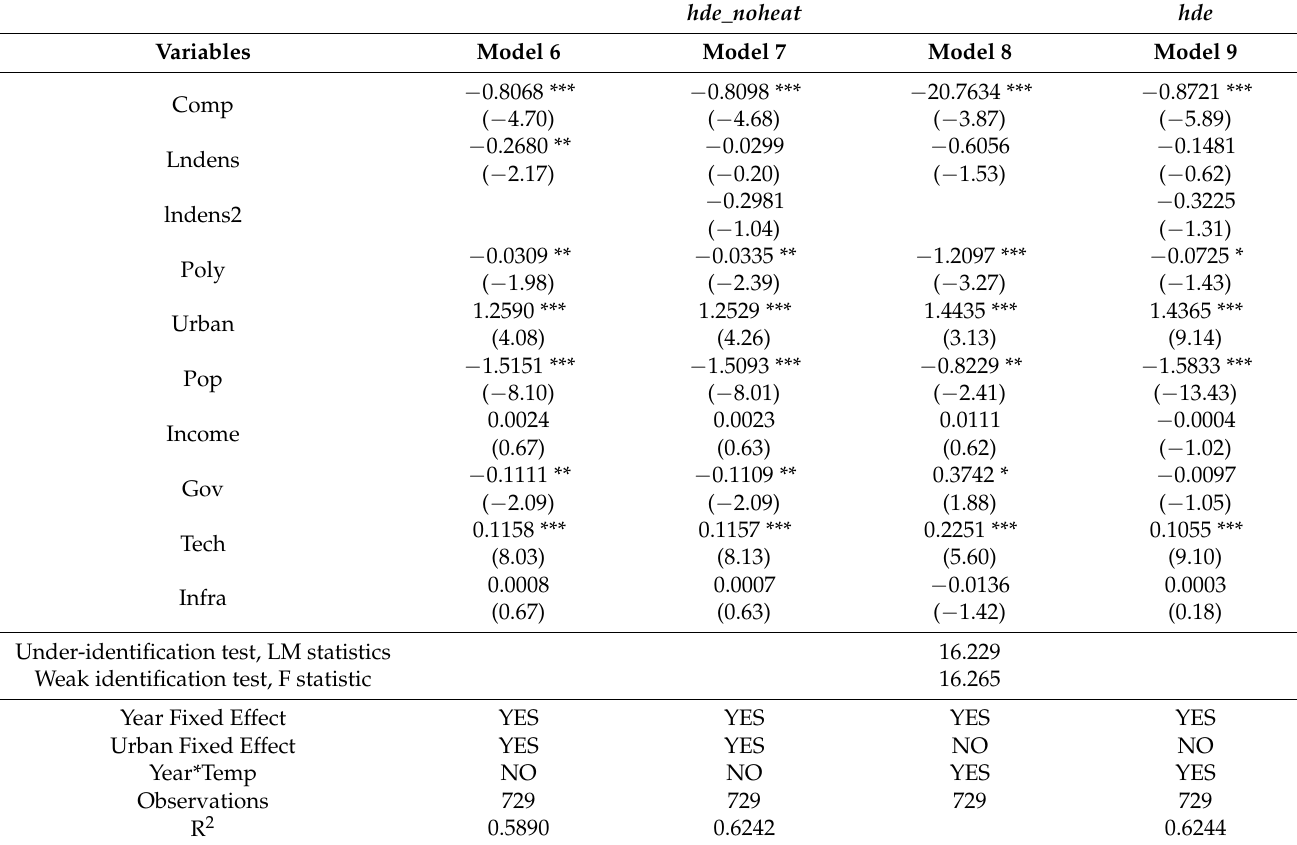
Table 4. Robustness